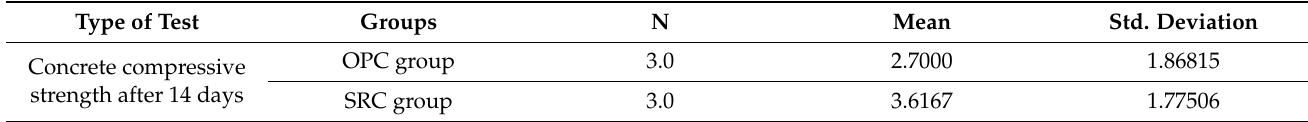
Table 10. Group statistics for concrete compressive strength test after 14 days.